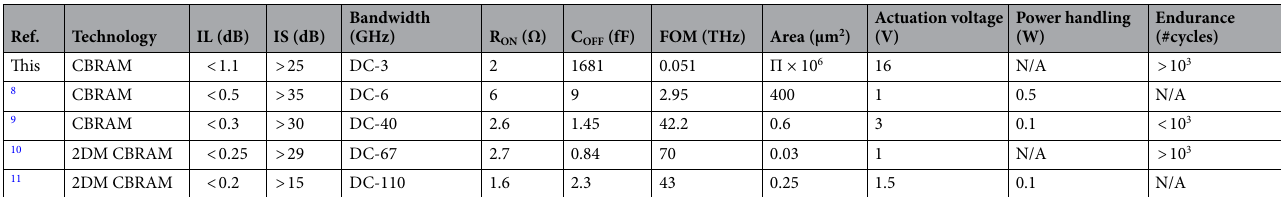
Table 3. A comparison between the performance obtained with our RF switch and the state of the art in the field of CBRAM RF switch.